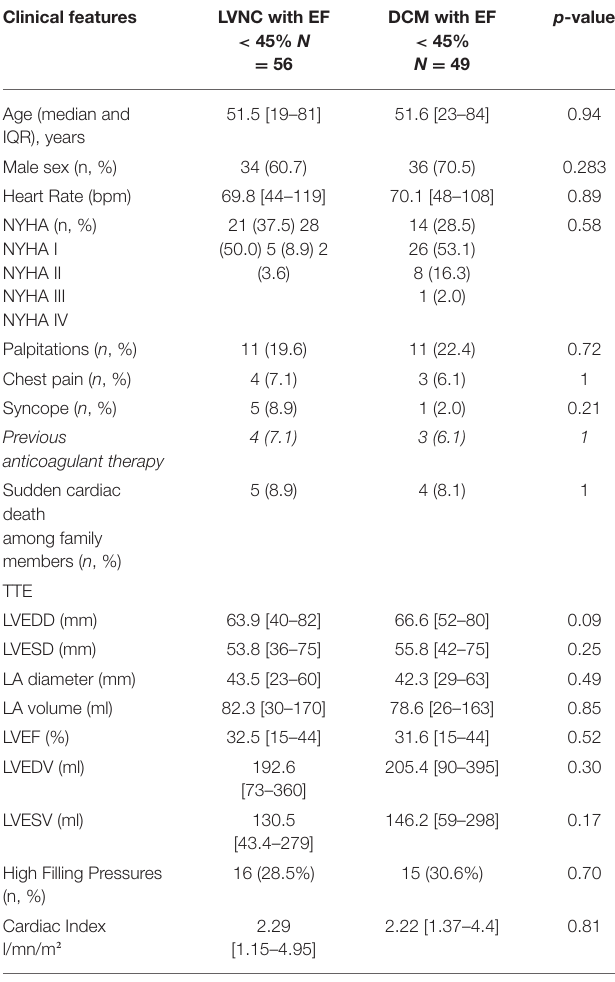
TABLE 2 | Clinical and echocardiographic features of LVNC with LVEF < 45% and DCM with LVEF < 45%. Clinical